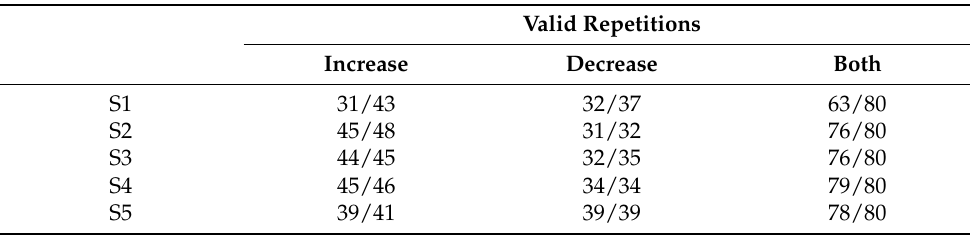
Table 1. Number of valid repetitions of each subject for the three types of models/total repetitions performed for each type of